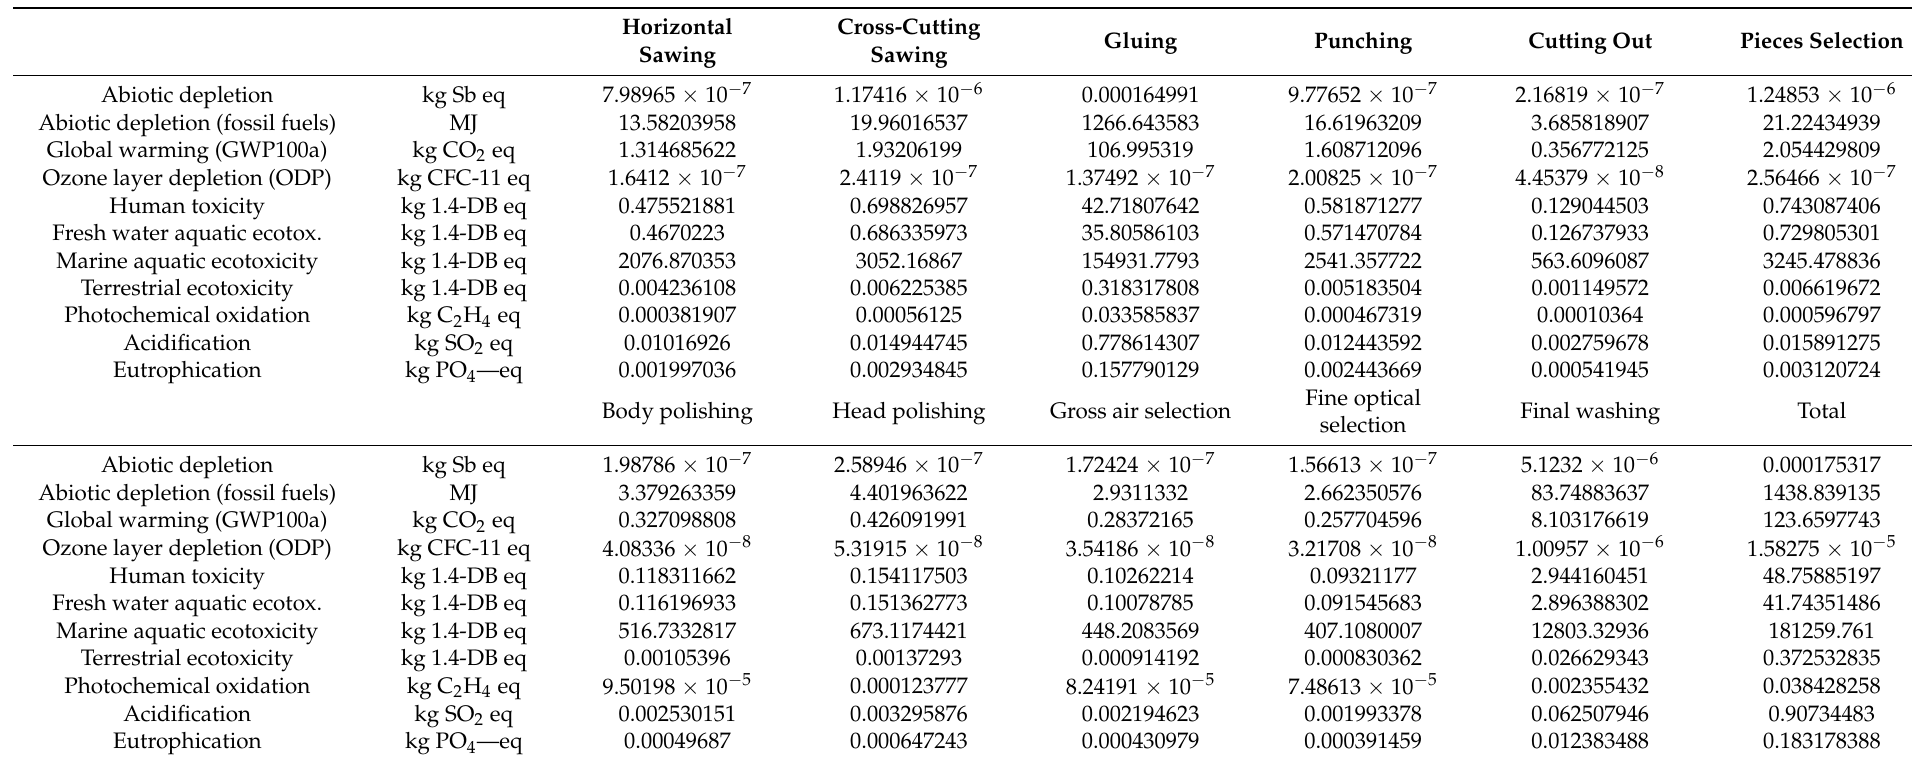
Table 11. Impact of stage 2 broken down by activities for the manufacturing process of 2-piece perforated stoppers with a diameter of 26 mm and 44 mm in length. Horizontal Cross-Cutting Gluing Punching Cutting Out Pieces Sawing Sawing